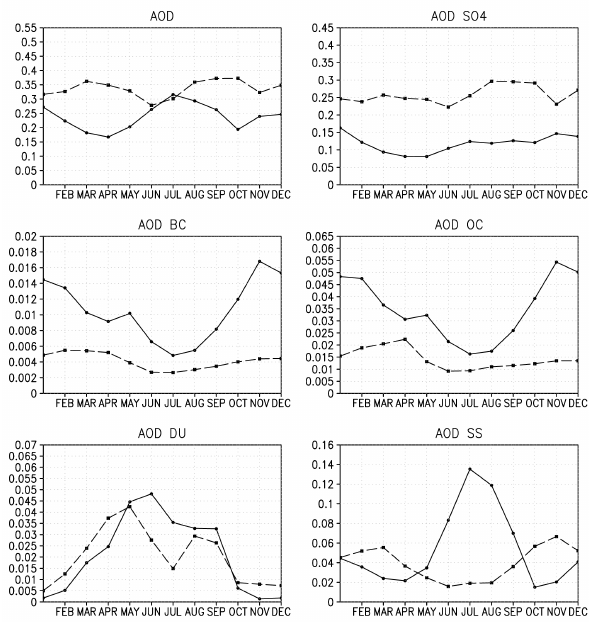
Fig. 10. Monthly mean AOD and contributions to it from different aerosol species for China (dashed line) and India (solid line), four- year average (2006–2009).